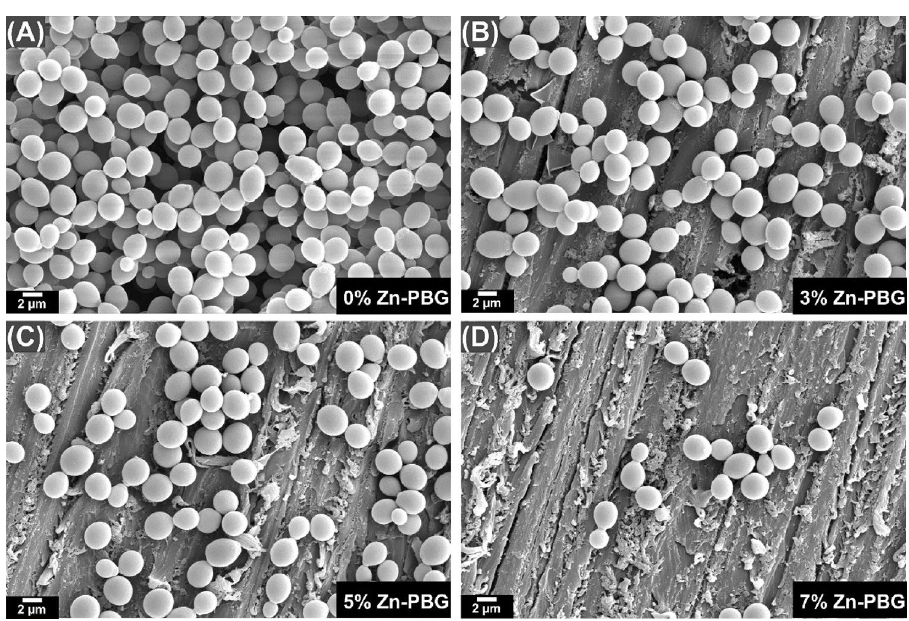
Figure 4. Representative scanning electron micrograph s of Candida albicans on the surfaces of various auto- polymerized acrylic resin samples: ( A ) control; ( B ) 3% Zn-PBG; ( C ) 5% Zn-PBG; ( D ) 7%